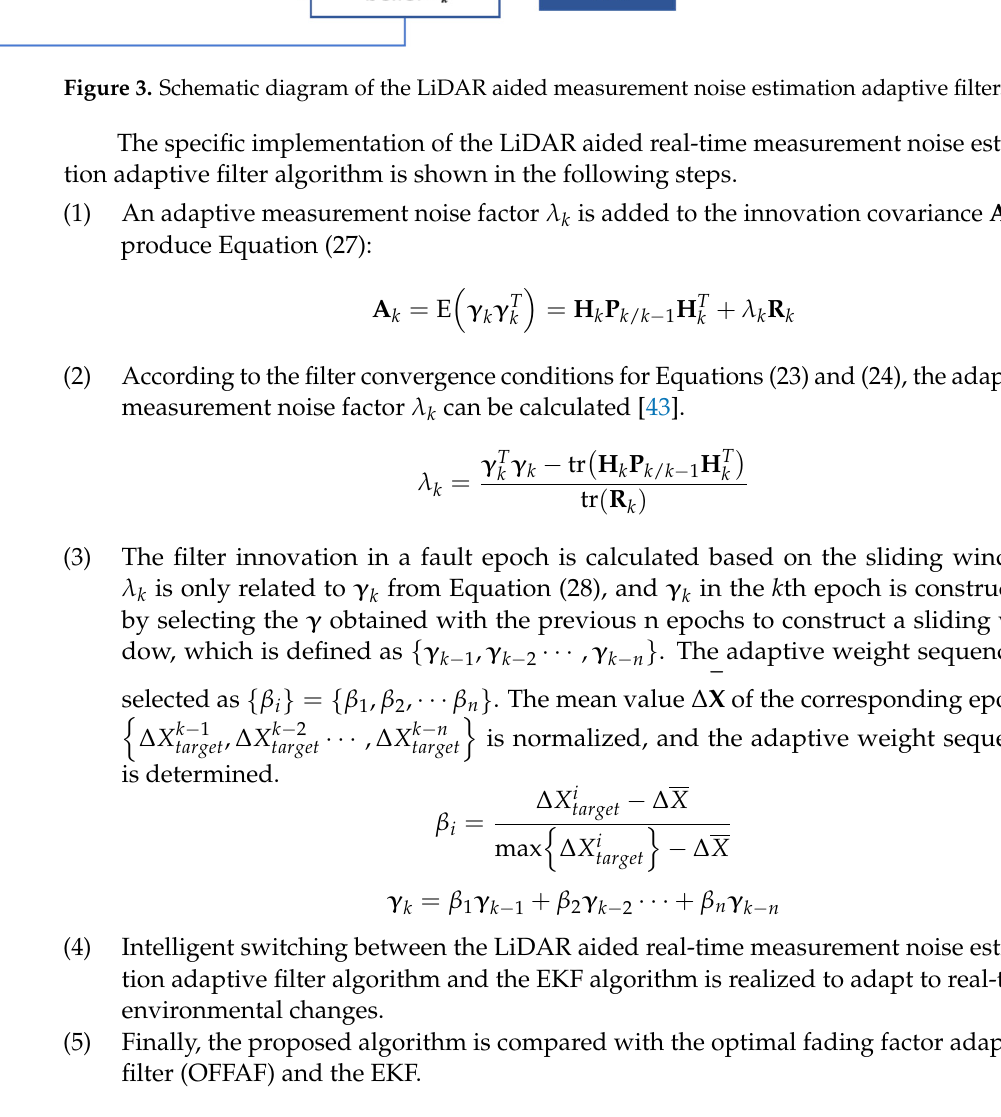
Intelligent switching between the LiDAR aided real-time measurement noise estima- tion adaptive filter algorithm and the EKF algorithm is realized to adapt to real-time environmental changes. Finally, the proposed algorithm is compared with the optimal fading factor adaptive filter (OFFAF) and the